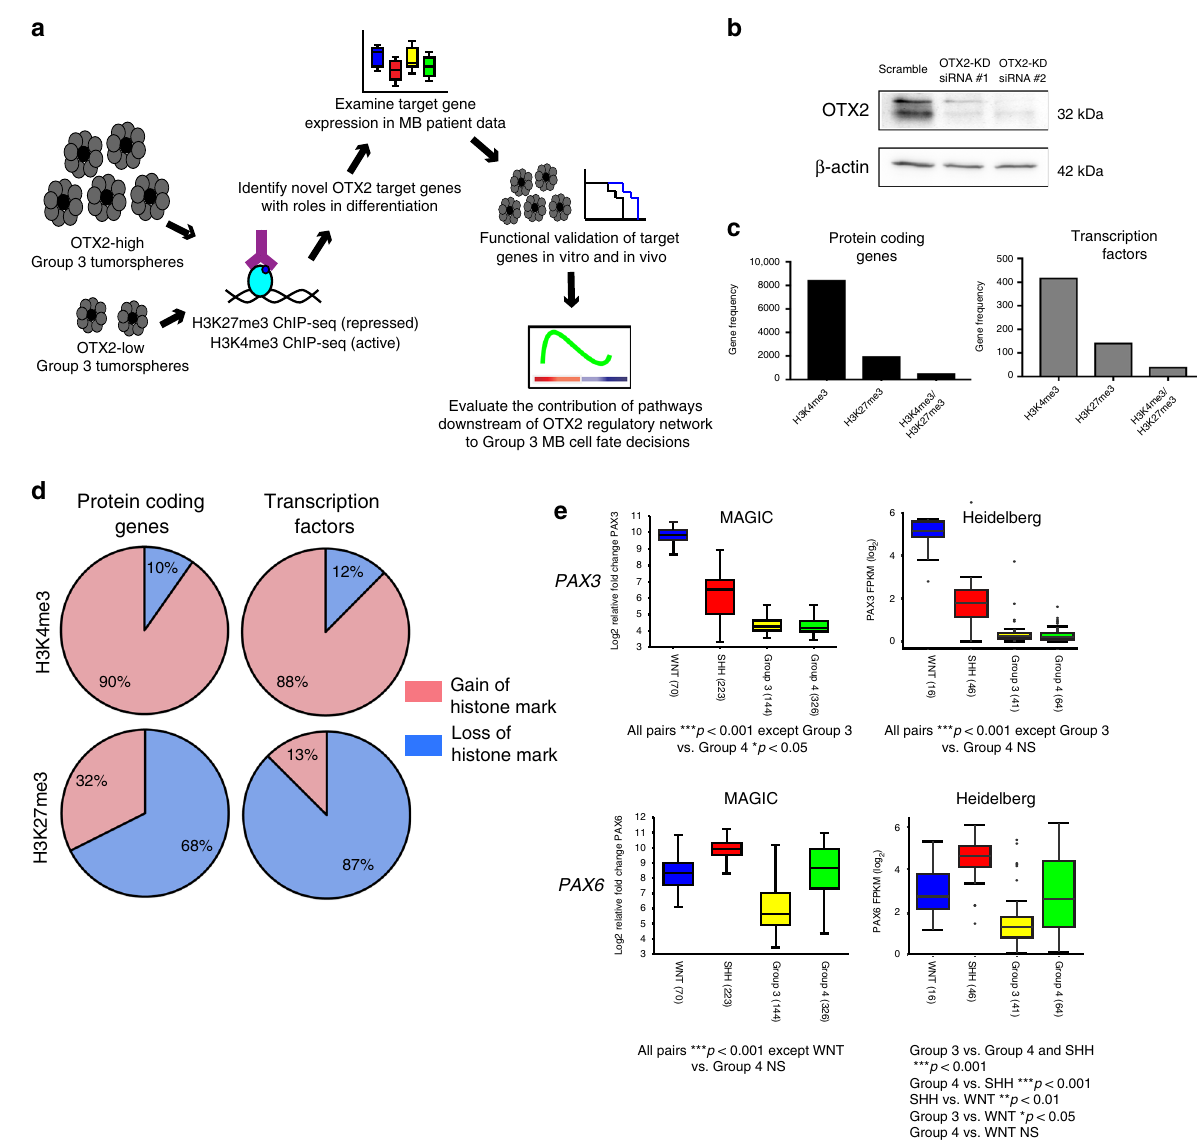
Fig. 1 PAX3 and PAX6 expression are reduced in Group 3 MB. a Work fl ow carried out to identify and characterize OTX2 target genes in Group 3 MB tumorspheres. b OTX2 silencing in D283 tumorspheres with two independent siRNAs after 24 h. β -actin serves as the loading control. c Number of protein-coding genes and transcription factors (TFs) with signi fi cant changes in H3K4me3 ( N = 8444 protein-coding genes, N = 419 TFs), H3K27me3 ( N = 2001 protein-coding genes, N = 144 TFs), and H3K4me3/H3K27me3 ( N = 564 protein-coding genes, N = 42 TFs) modi fi cations following OTX2 silencing in D283 tumorspheres. d Proportion of protein-coding genes and TFs, with speci fi c gain or loss of H3K4me3 or H3K27me3 modi fi cations, respectively. e PAX3 (upper) and PAX6 (lower) expression analyses across the four medulloblastoma subgroups in two independent patient cohorts (MAGIC, N = 763 patient samples; Heidelberg, N = 167 patient samples) show lower PAX3 and PAX6 expression in Group 3 MB. The center line represents the median, the box represents the interquartile range, and the whiskers are the 95% con fi dence intervals. Data are presented as log2-transformed signal intensity. For the Heidelberg dataset, the outliers are de fi ned as circles above and below the whiskers. Data are presented as log2-transformed signal intensity. For MAGIC cohort: PAX3 expression: all pairs *** p < 0.001 with the exception of Group 3 vs Group 4 * p < 0.05. PAX6 expression: all pairs *** p < 0.001 with the exception of WNT vs Group 4 NS. For Heidelberg cohort: 167 patients. PAX3 expression: all pairs *** p < 0.001 with the exception of Group 3 vs Group 4 NS. PAX6 expression: Group 3 vs Group 4 and Group 3 vs SHH *** p < 0.001. Group 4 vs SHH *** p < 0.001. SHH vs WNT ** p < 0.01. Group 3 vs WNT * p < 0.05. Group 4 vs WNT NS. Signi fi cance was determined by ANOVA with Tukey ’ s multiple